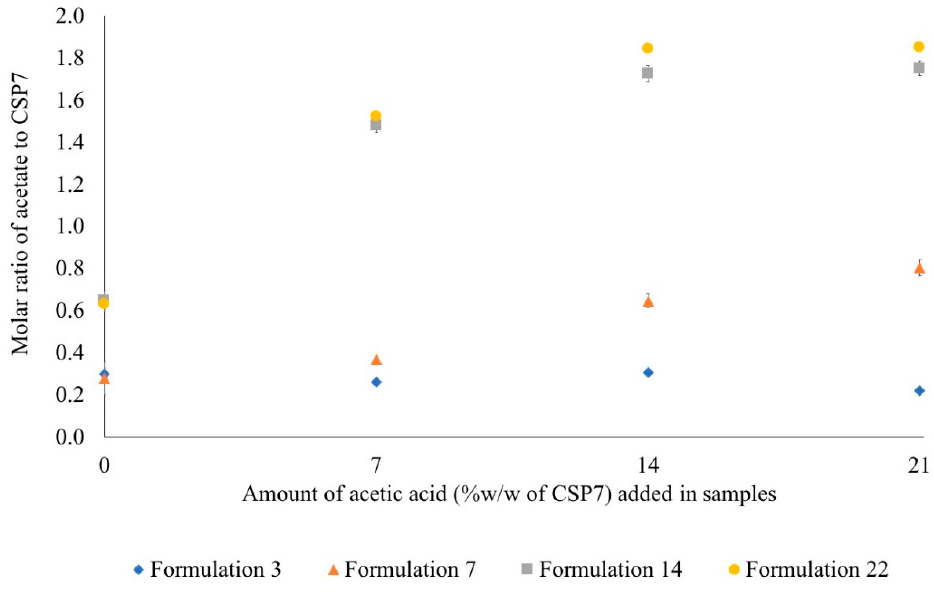
Figure 11. Molar ratio of counterions to CSP7 in lyophilized formulations containing varying amounts of acetic acid.